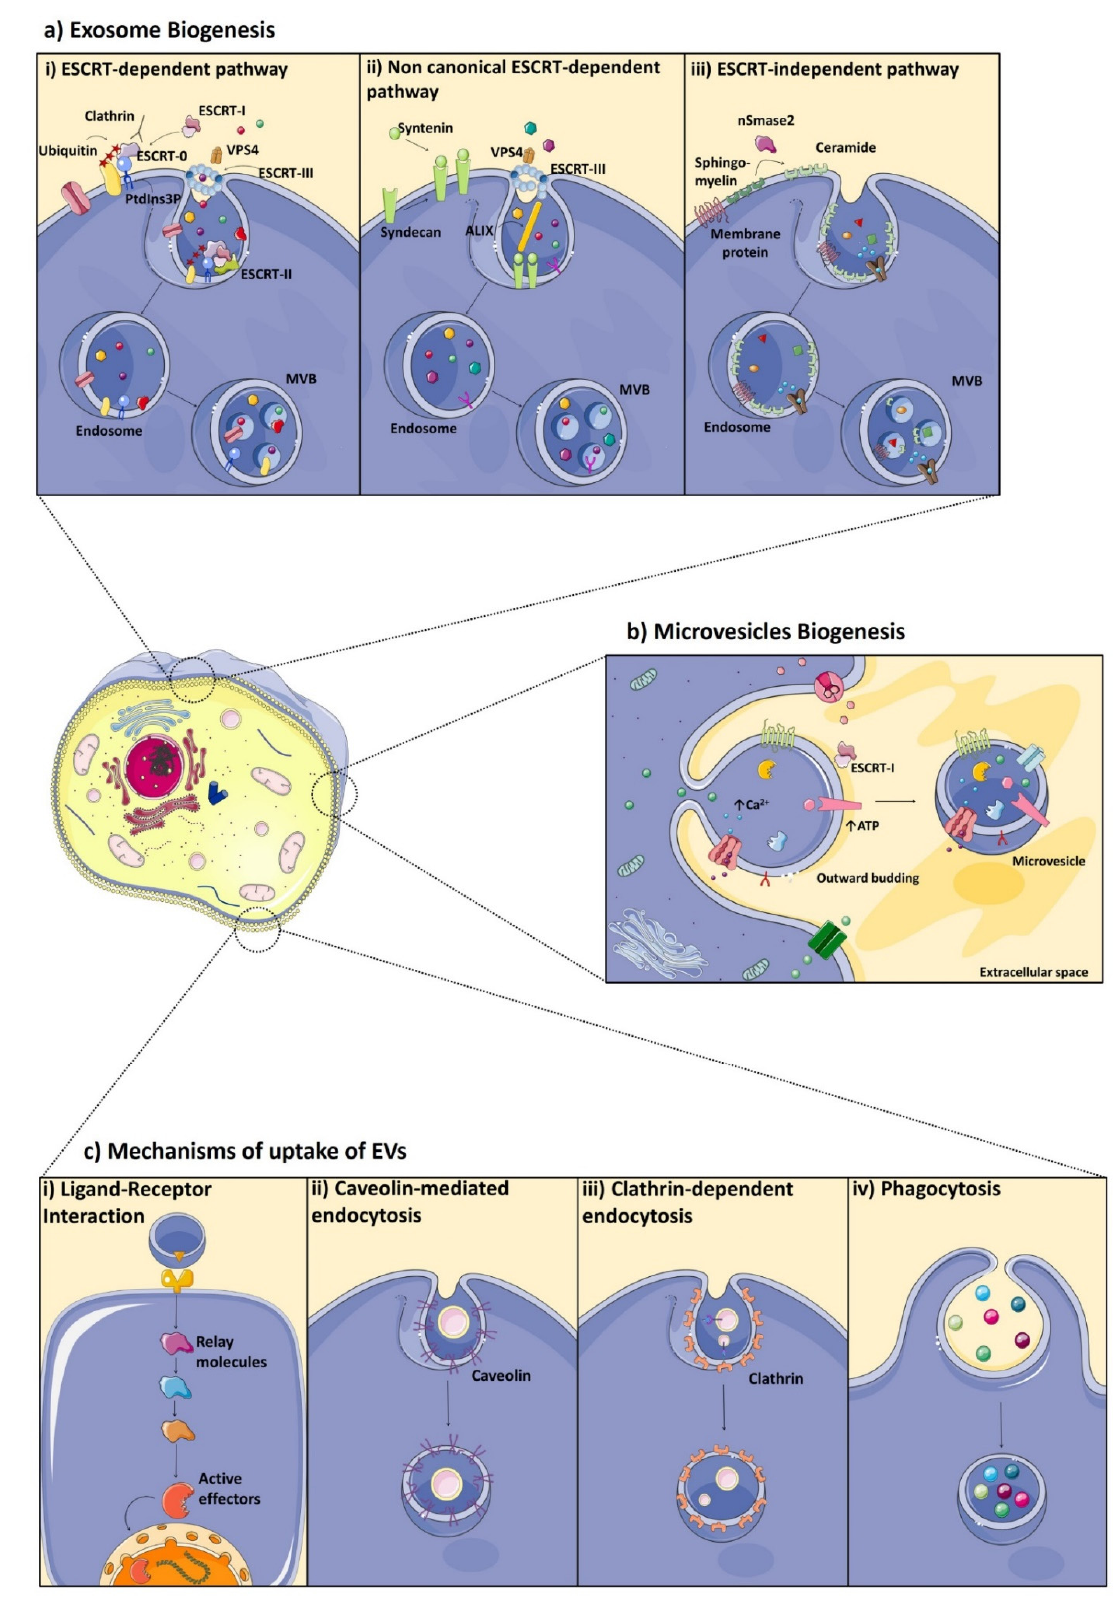
Figure 1. Extracellular vesicles formation: ( a ) exosome biogenesis. ( i ) the ESCRT-dependent pathway. In the canonical ESCRT-dependent pathway, phosphatidylinositol-3-phosphate (PtdIns3P) recruits the ESCRT-0 (STAM1, HRS) to